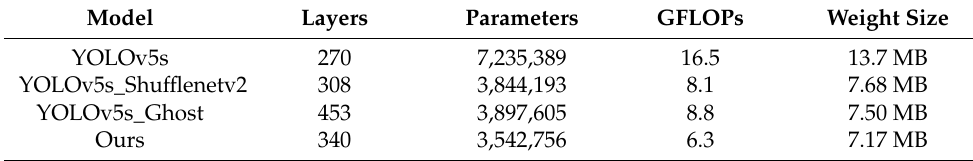
Table 3. Comparison of parameters of different lightweight network